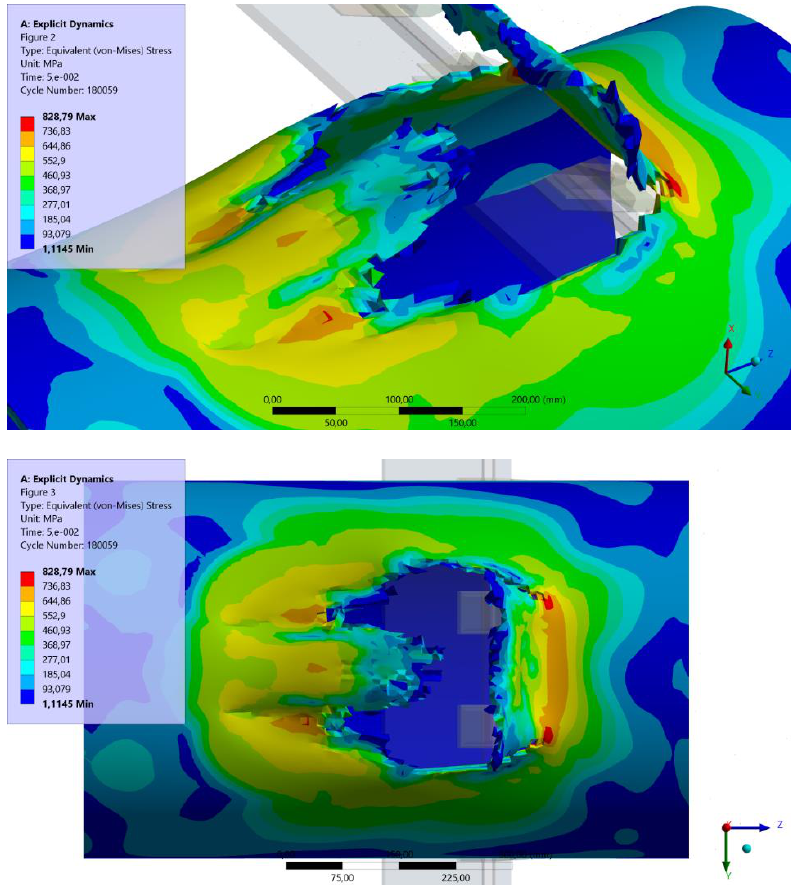
Figure 13. Development of the pipeline destruction at the bucket position according to Variant 1.